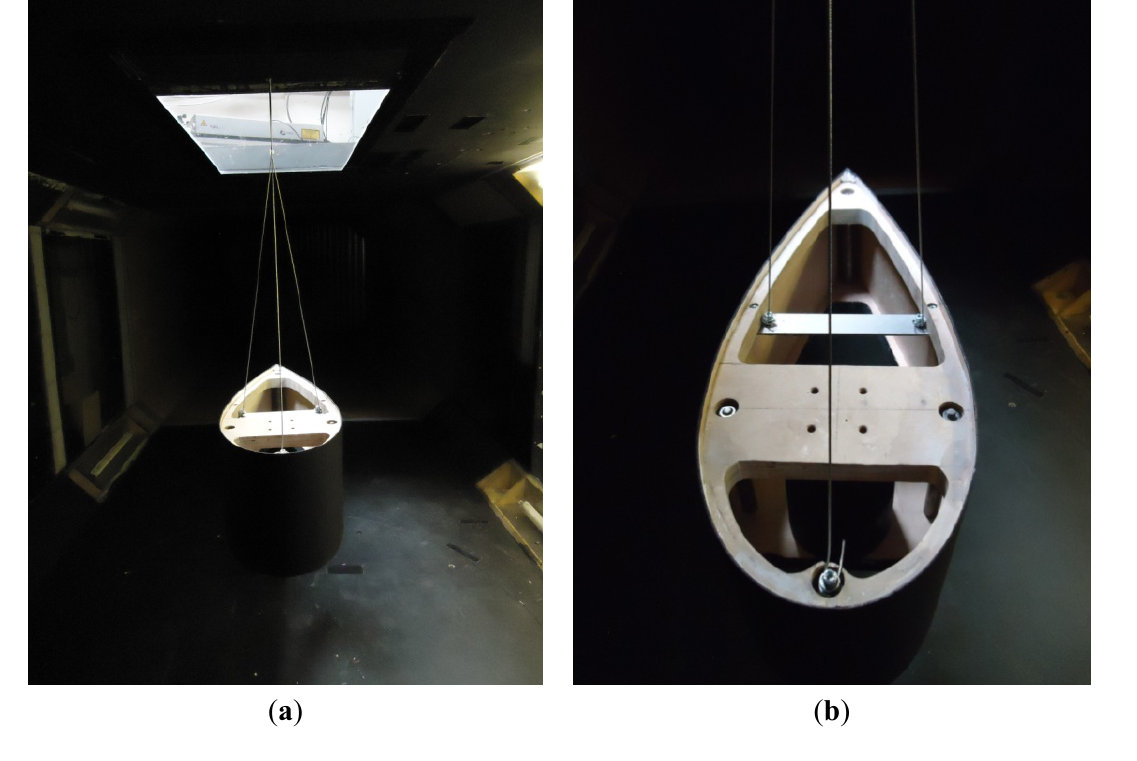
Figure 13. ( a ) Wing Suspended for Dynamic Test; ( b ) Wing with Internal